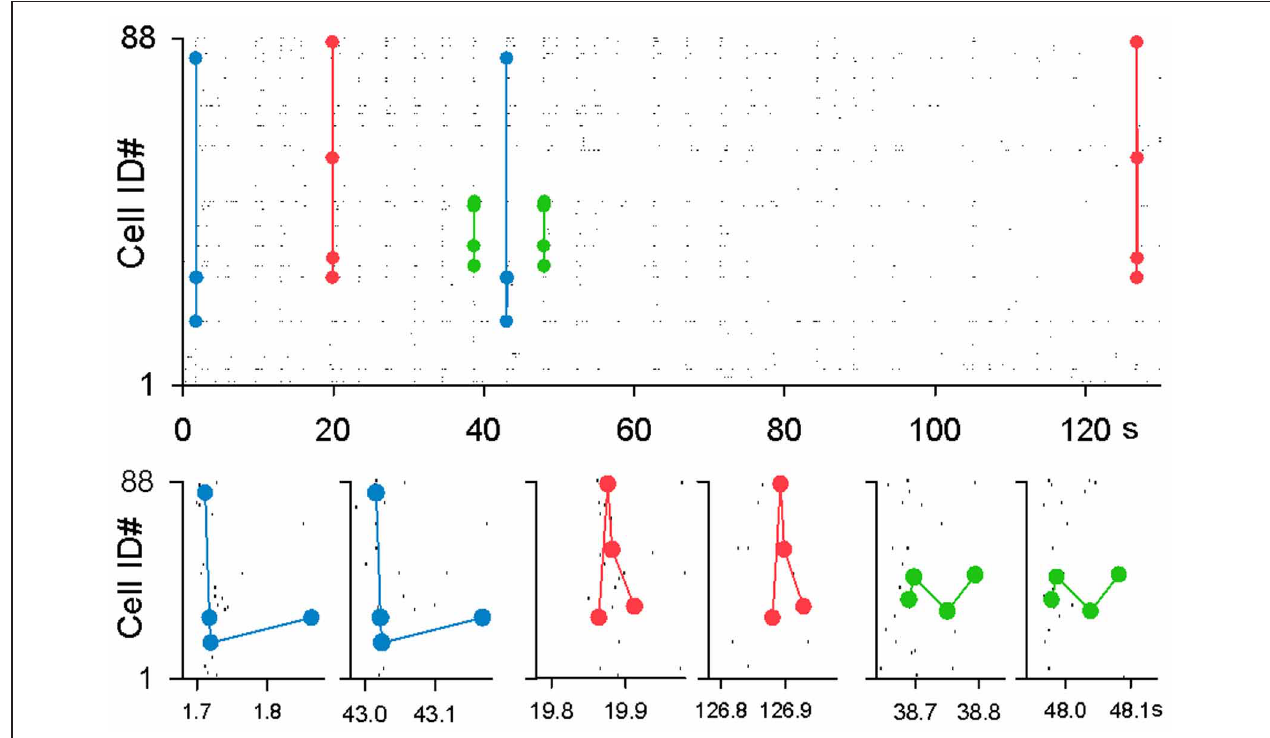
FIGURE 2 | Examples of MSSs. Three representative MSSs are merged in a single rastergram and magnified in time in the bottom panels.